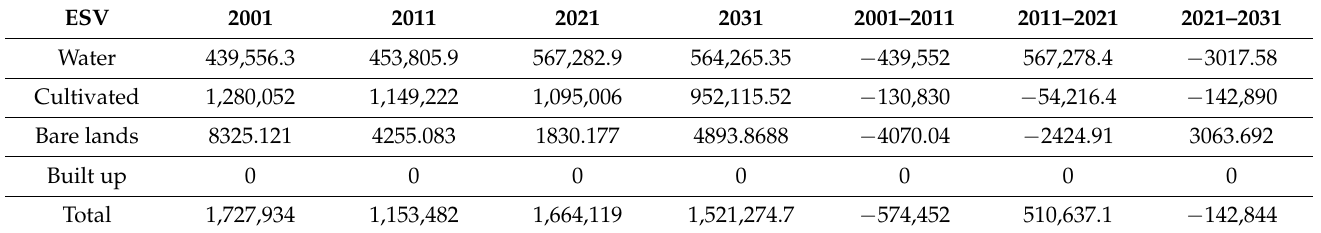
Table 13. Ecosystem Service Values (ESVs; USD) for each LULC type of Damietta